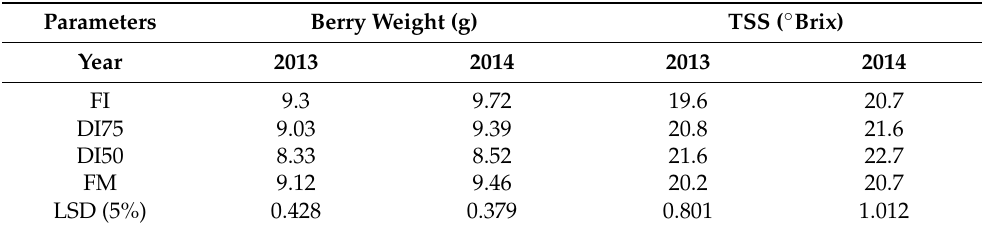
Table 3. Grape fruit yield and quality under irrigation strategies for the study periods 2013 and 2014.